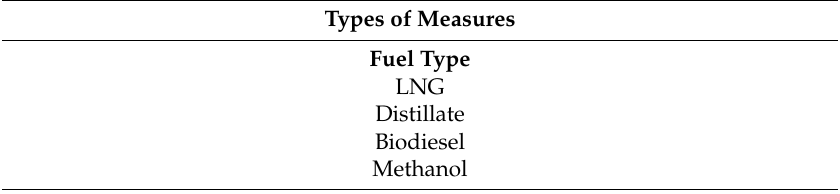
Table 8. Appropriate BC Emission Control Measures a